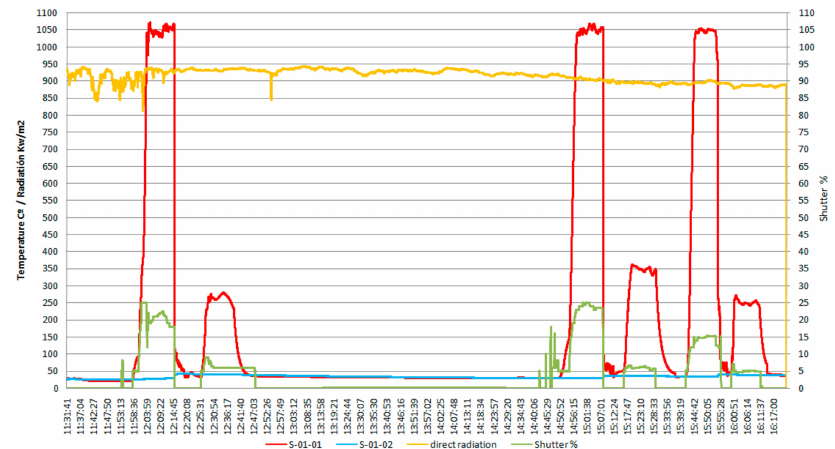
Figure 3. The specific diagram for the heat treatments applied to the AISI 316 modified stainless steel